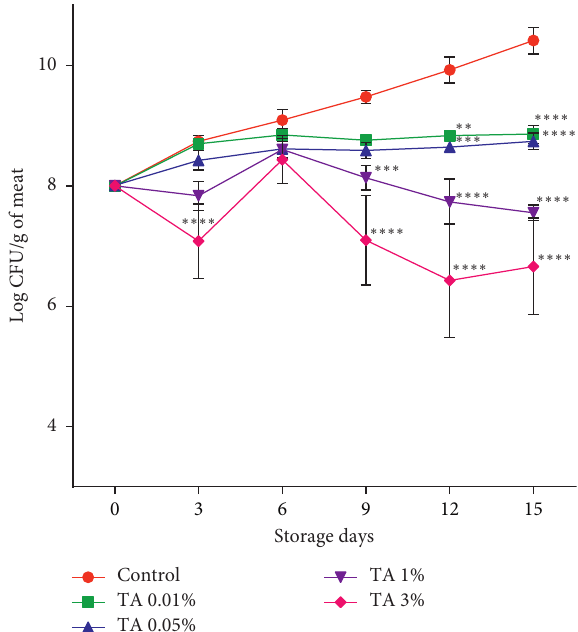
Figure 3: Time-related survival, at 4 ° C, of the high meat con- tamination level (10 8 CFU/g) of P. aeruginosa , following treatment with increasing concentrations of T. algeriensis EO. The results represent the means of three replicate experiments, and error bars represent the standard error of the mean. Statistical significance differences: ∗ p < 0 . 05 (significant), ∗∗ p < 0 . 01 (very significant), and ∗∗∗ p < 0 . 001 and ∗∗∗∗ p < 0 . 0001 (extremely significant). CFU: colony-forming unit; TC: Thymus algeriensis